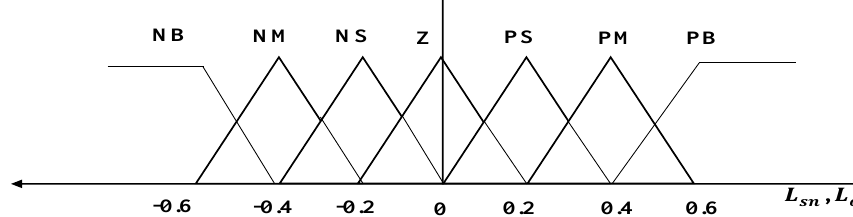
Figure 4. Input membership functions.